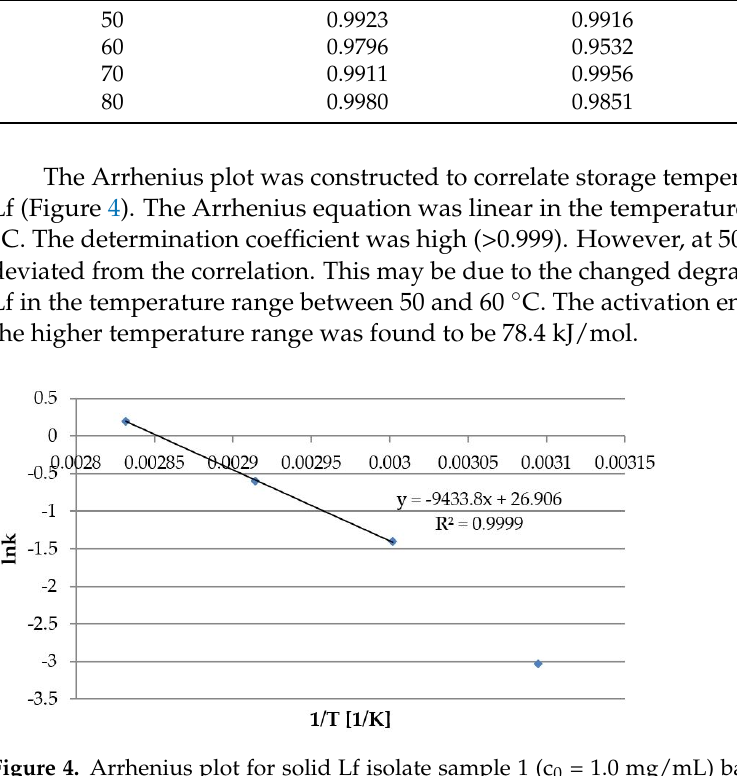
Table 7. Degradation rate constants for various Lf samples at different temperatures.